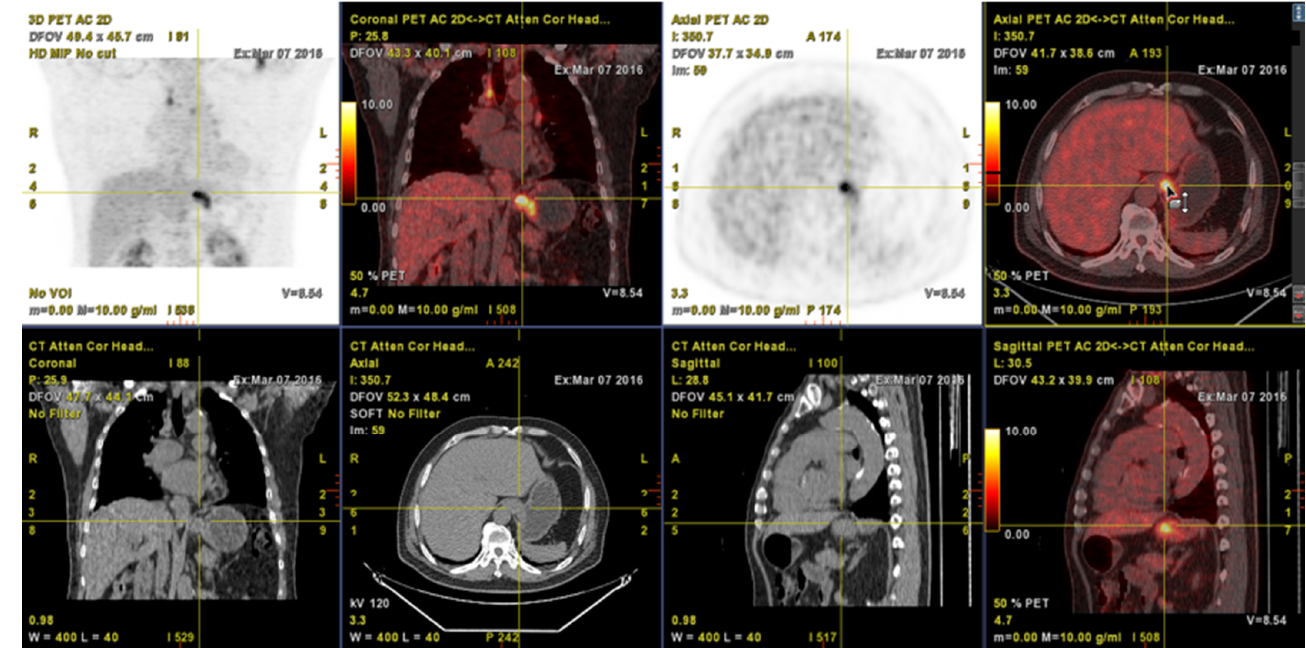
Figure 1. A 78 y/o male patient was diagnosed cT2N0M0, stage II on pre-treatment 18 F-FDG PET/CT. The small tumor mass with FDG hot uptake was noted on 18 F-FDG PET/CT (yellow color cross indicator). Metabolic parameters showed SUVmax: 7.61, SUVmean: 4.65, MTV: 11.07 cm 3 , and TLG: 51.41g/mL ∗ cm 3 by the PET VCAR. He underwent CRT treatment and expired 3.9 months later due to disease progression.